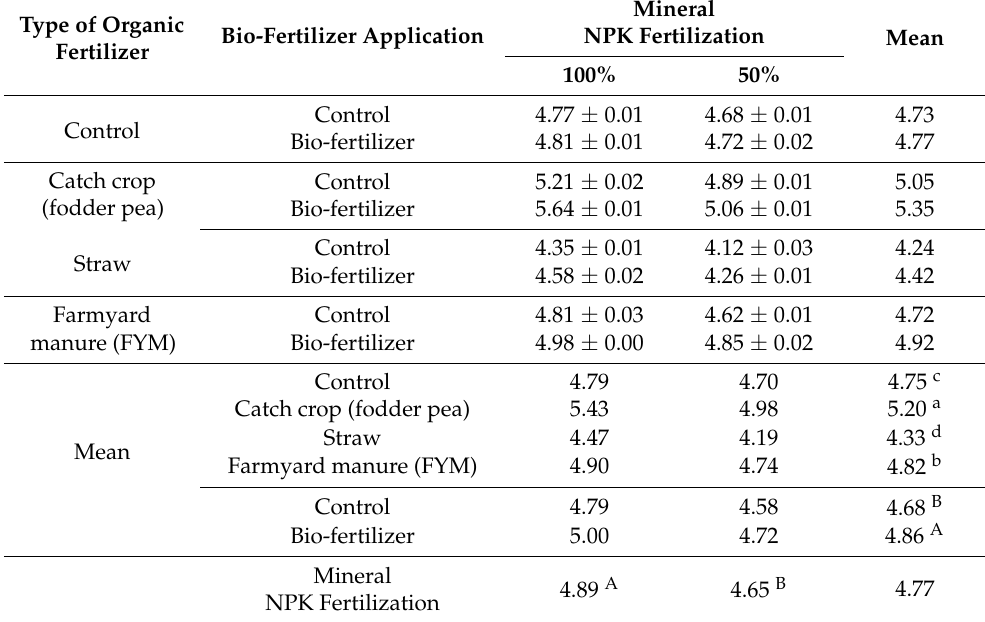
Table 5. Total polyphenols content in potato tubers after harvest depending on the applied research factors (mg GAE kg –1 DM) (mean from 3